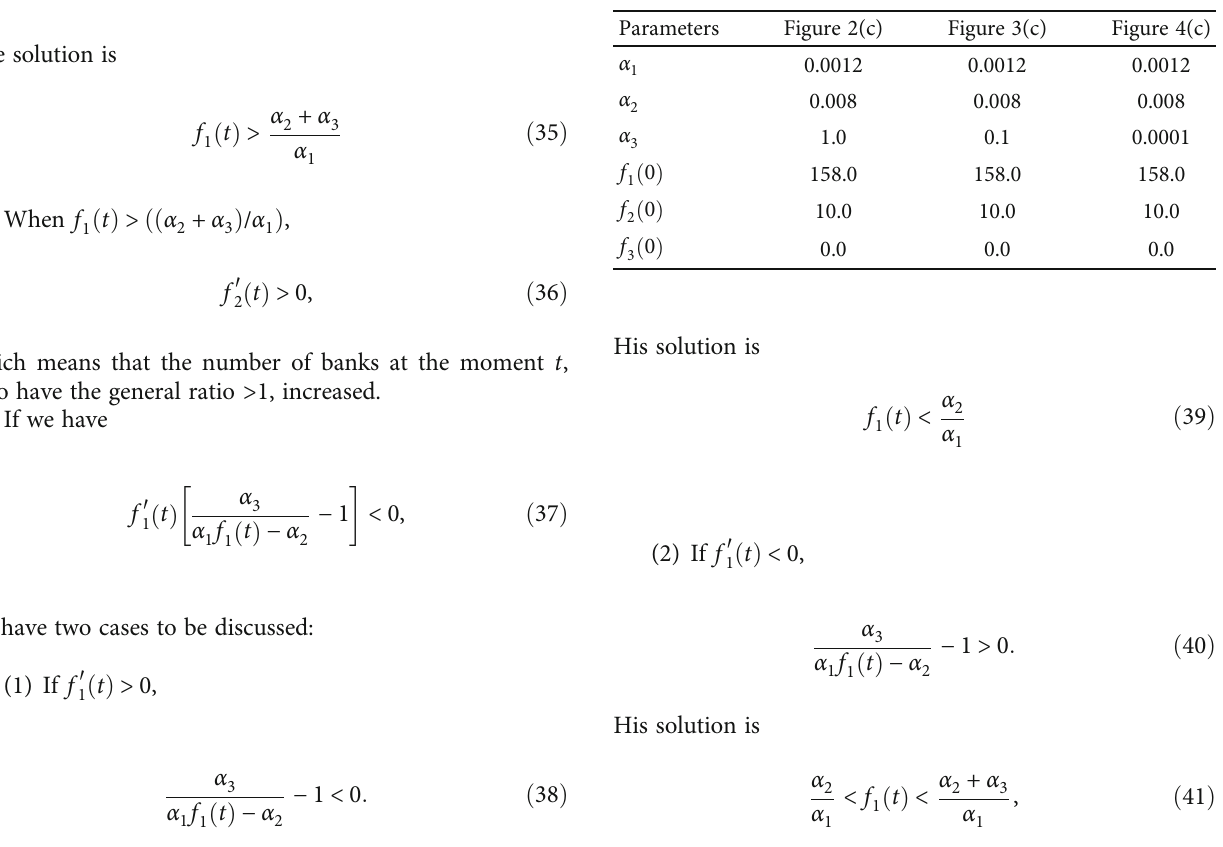
Table 3: The values of initial parameters conditions of the model (1) in